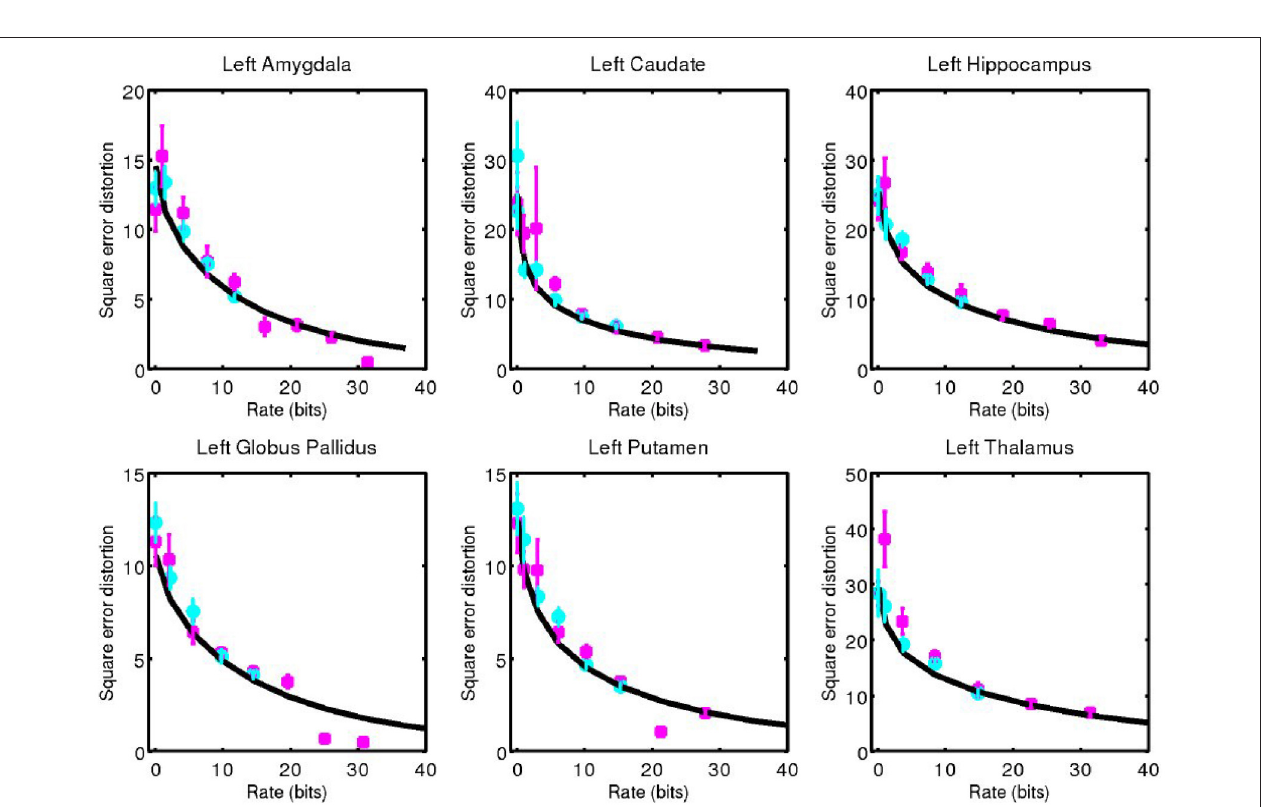
FIGURE 5 | Square error distortion as a function of code rate for left side structures. Coding one structure is shown in magenta, and two structures simultaneously is shown in cyan. The rate distortion curve for a multivariate Gaussian model is shown in black.